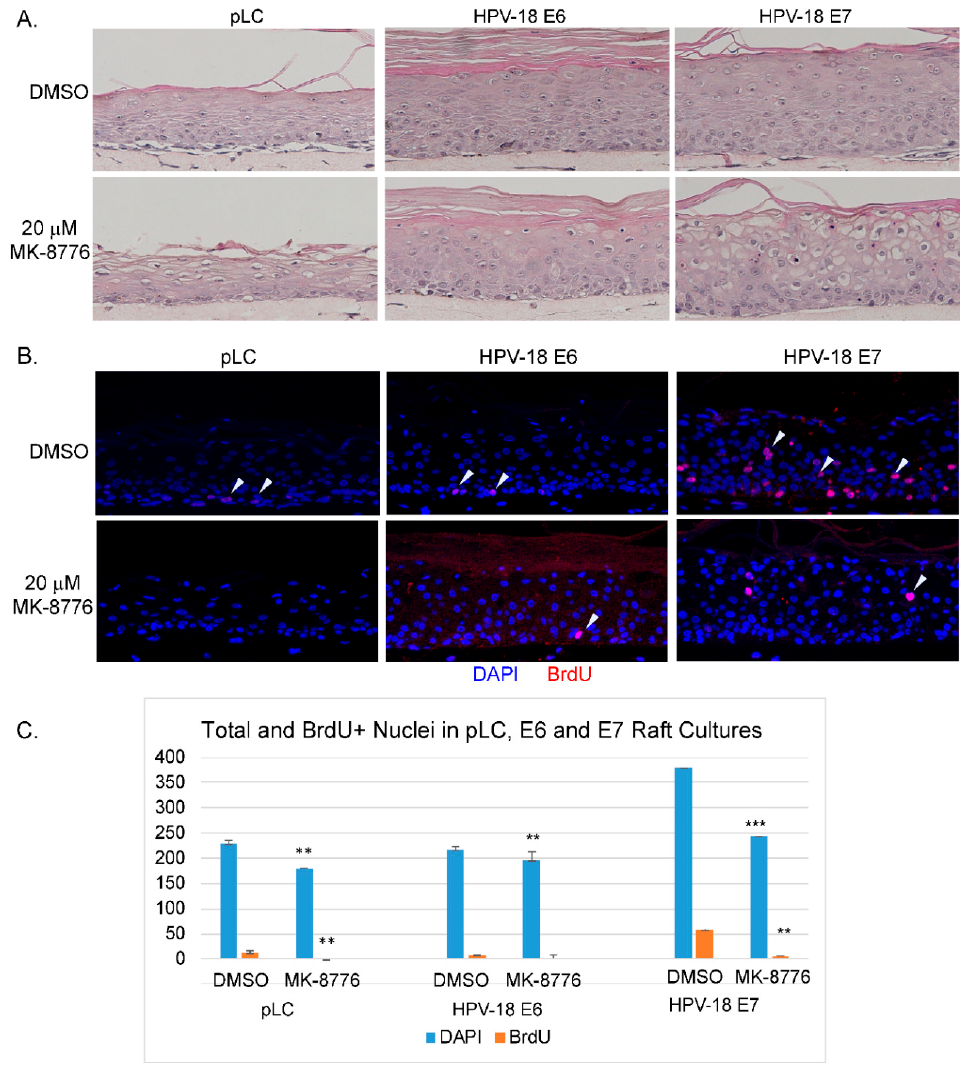
Figure 5. HPV-18 E7 sensitizes PHK raft cultures to Chk1 inhibitor MK-8776. ( A ) Hematoxylin and eosin staining of raft cultures PHK containing empty vector (pLC), HPV-18 E6 or HPV-18 E7. The cultures were exposed to DMSO or 20 µM MK-8776 from days 8 to 12. Enlarged vacuolated cells with condensed nuclei were most prominent in the E7-expressing culture. ( B ) IF assay to detect BrdU (red) incorporation in the above raft cultures. Arrow heads indicate to the BrdU signals. ( C ) Significant inhibition of DNA replication by MK-8776 in raft cultures. Quantitative representation of total and BrdU positive nuclei from 3 microscopic fields in raft culture sections. The p values (determined by a student’s t -test using MS Excel) are indicated with ** ( < 0.05) or *** ( < 0.005). Images were captured with 20 ×